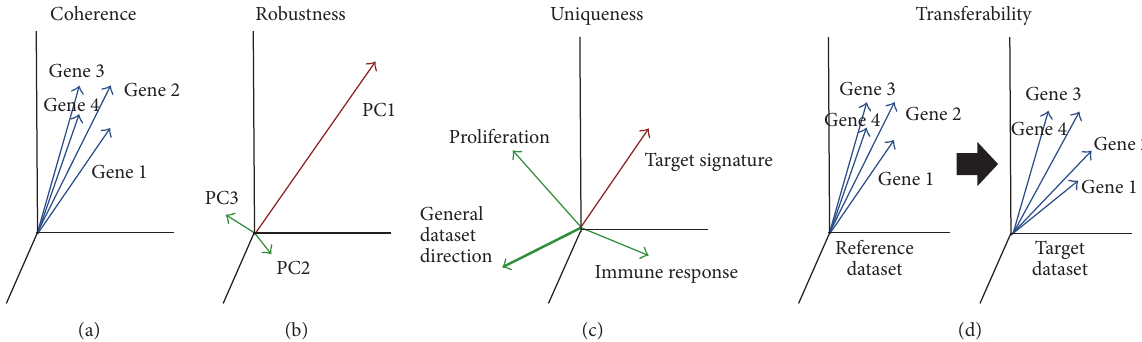
Figure 1: Conceptual view of how a good PCA-based gene signature should behave. The genes in a signature should be coherently expressed within the data (a). A signature should represent a single biological effect (b). A signature should represent unique and distinct signal within the data (c). A signature should represent the same biology as a known reference dataset